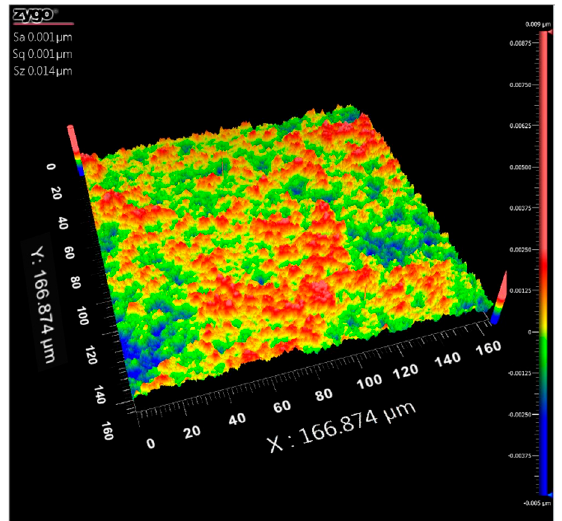
Figure 7. The morphology of the sputtered aluminum film measured by the white-light interferometer.